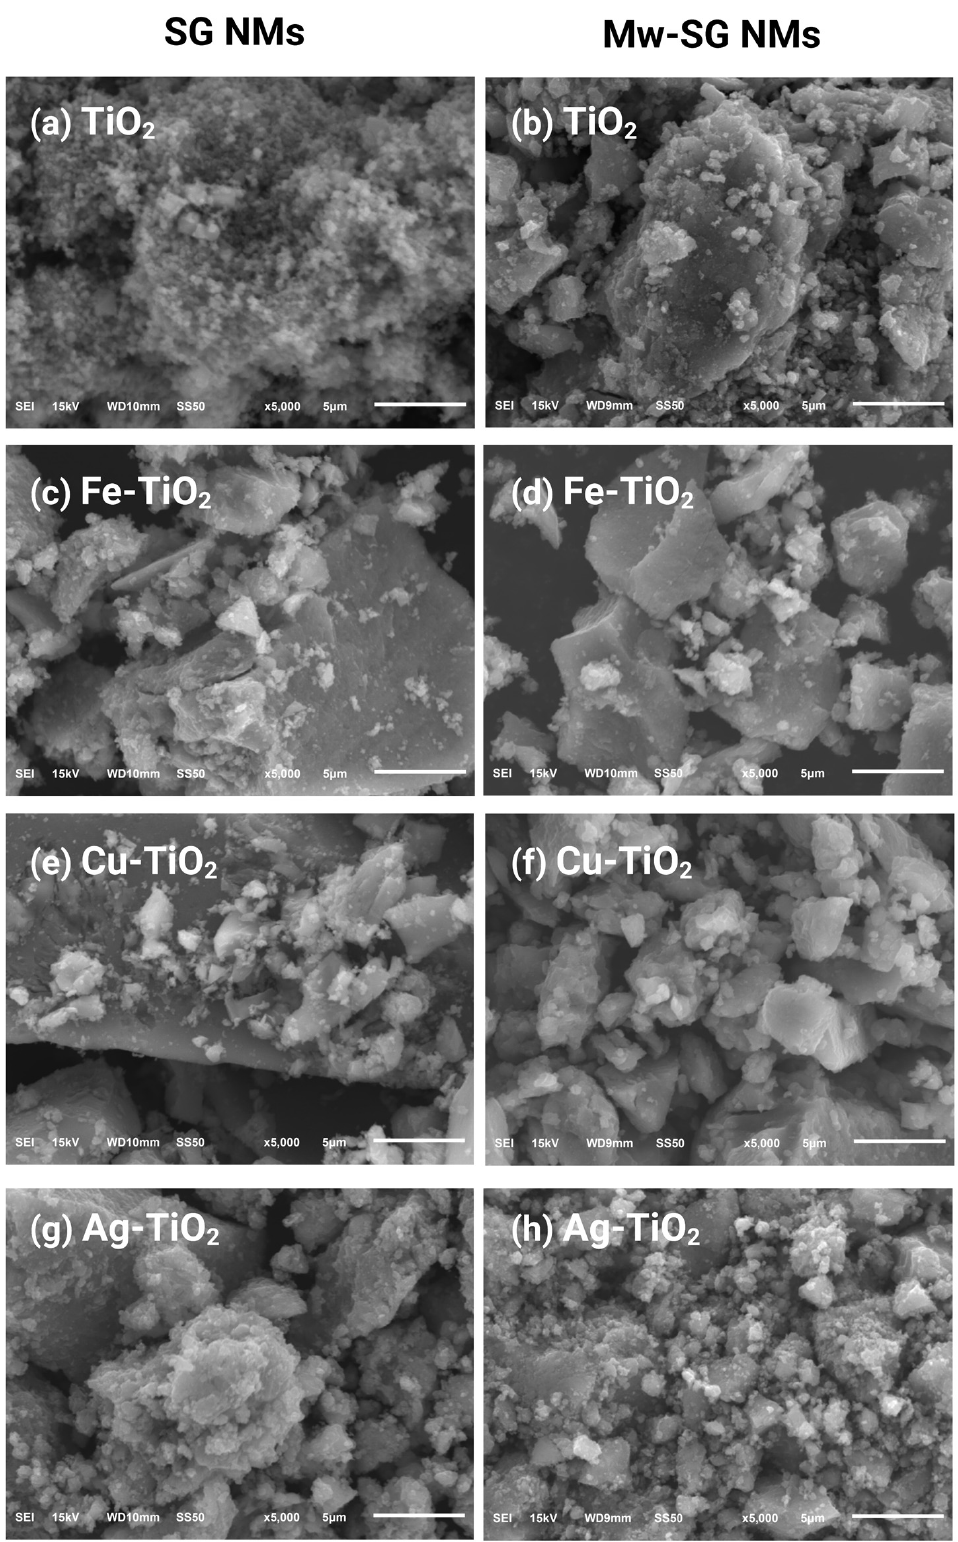
Figure 1. SEM images (5000×) of the SG- and Mw-SG-synthesized materials, ( a , b ) TiO 2 , ( c , d ) Fe-TiO 2 , ( e , f ) Cu-TiO 2 , ( g , h ) Ag-TiO 2 .